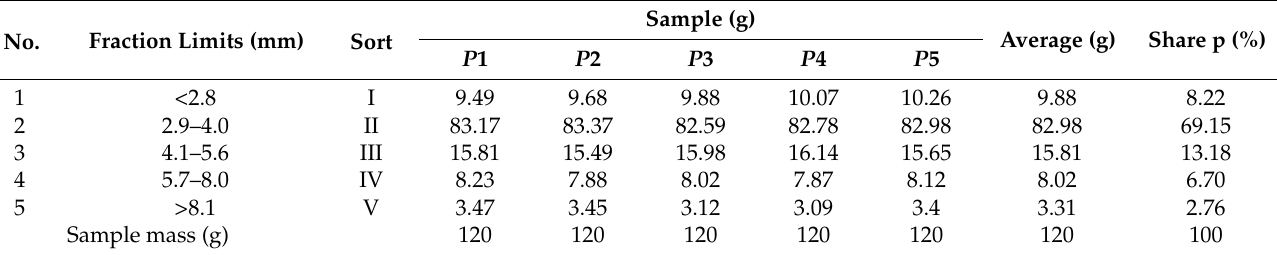
Table 2. Distribution of nettle fragments chopped at 4